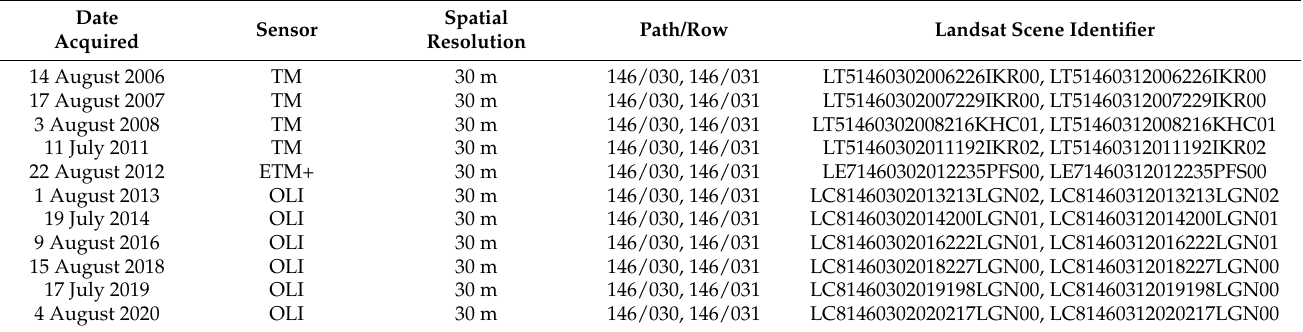
Table A1. Information about Landsat remote sensing data used in this